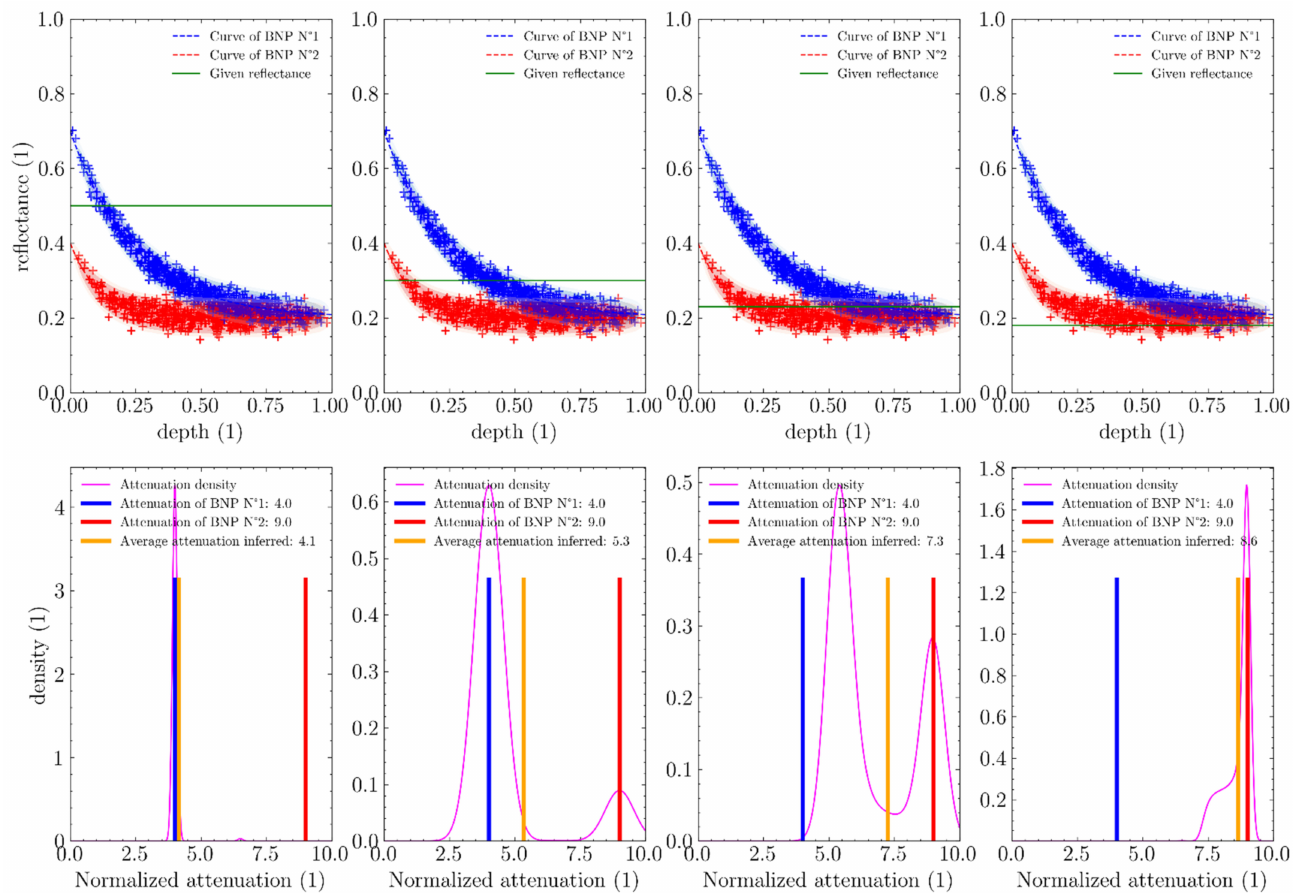
Figure 22. Inference of the attenuation coefficient c in a two-component BNP mixture for a given input reflectance (horizontal green line). The sample cloud is made of red and blue points, each artificially generated from two BNPs